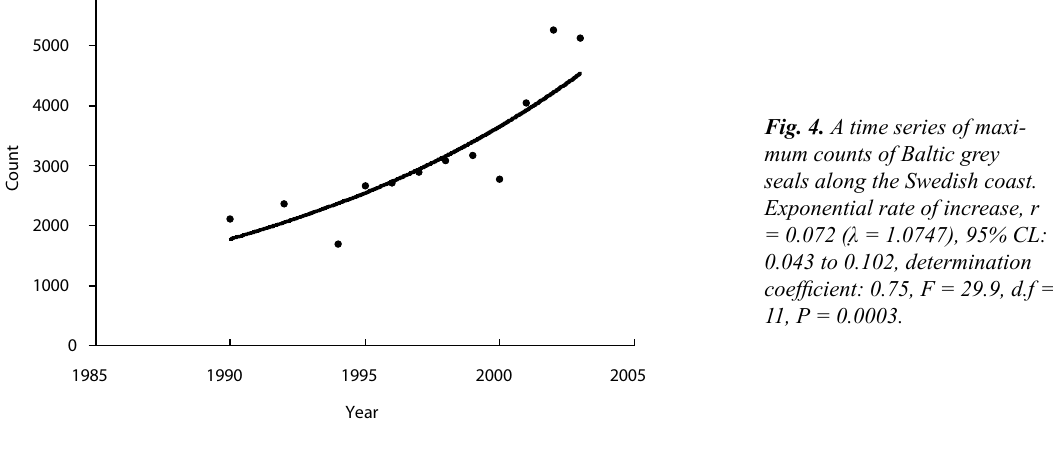
Fig. 4. A time series of maxi - mum counts of Baltic grey seals along the Swedish coast. Exponential rate of increase, r = 0.072 (λ = 1.0747), 95% CL: 0.043 to 0.102, determination coefficient: 0.75, F = 29.9, d.f = 11, P =